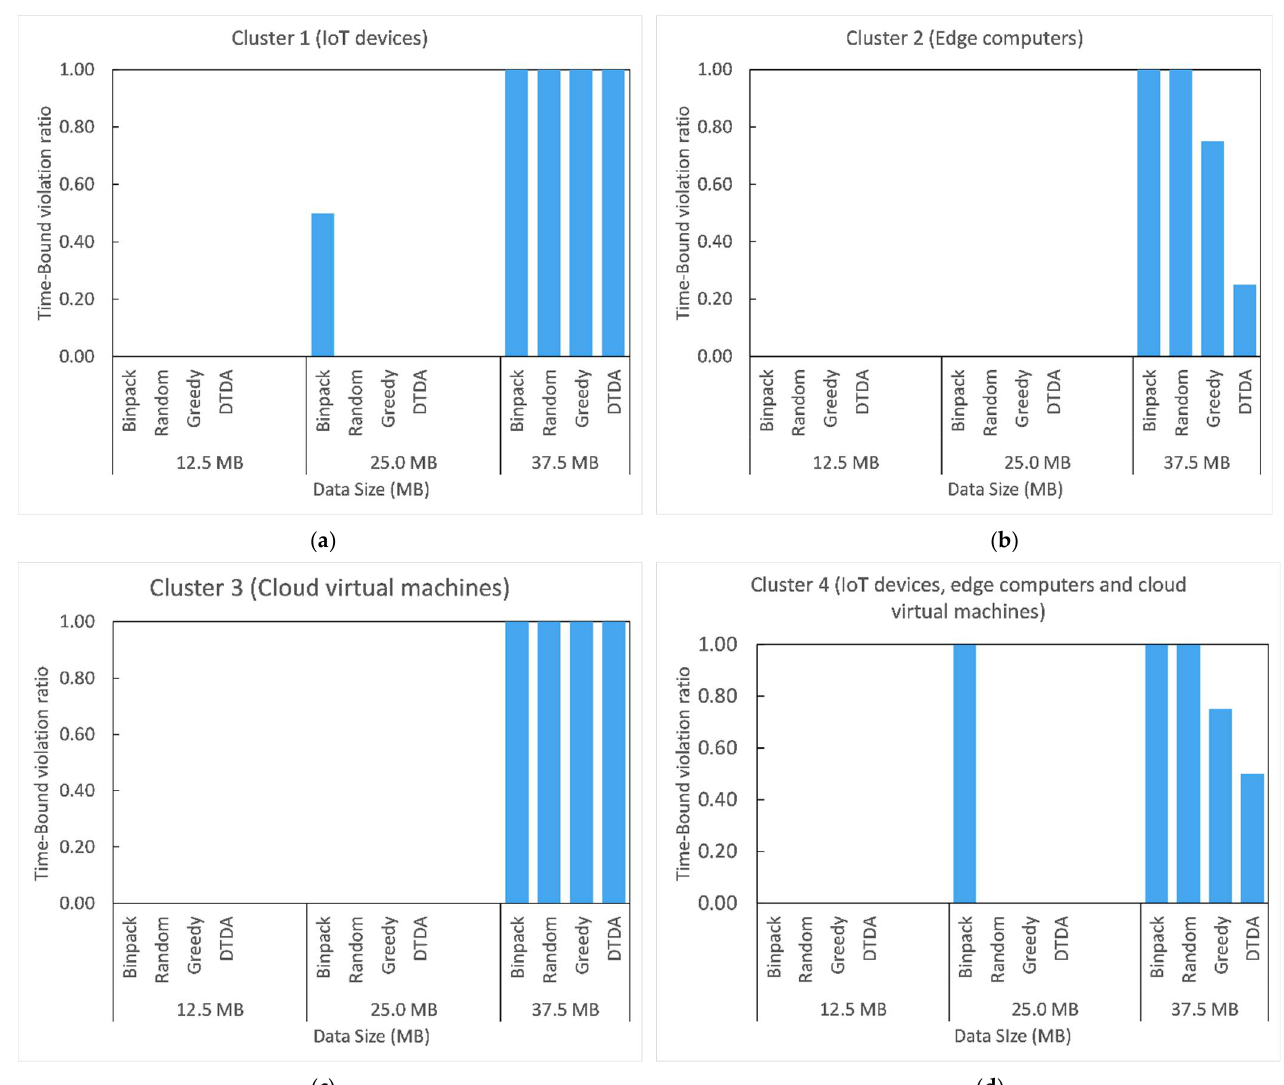
Figure 10. Comparison of the time-bound violation ratio of task management techniques under different computing resource clusters and varying data sizes. ( a ) Cluster 1 (IoT devices). ( b ) Cluster 2 (edge computers). ( c ) Cluster 3 (cloud virtual machines). ( d ) Cluster 4 (IoT devices, edge computer and cloud virtual machines).